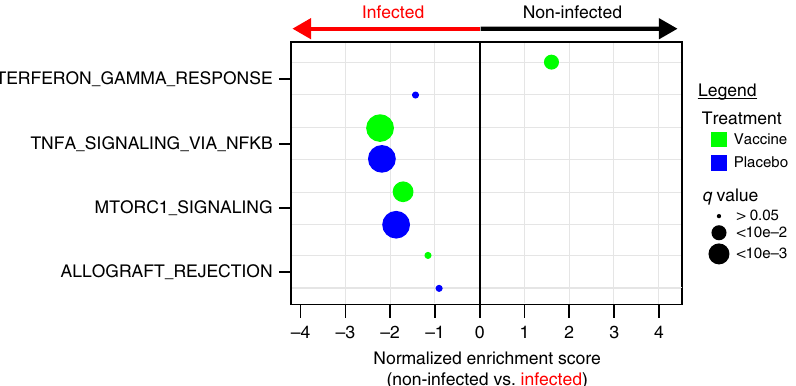
Fig. 3 IFN γ response associated with the reduction of the risk of HIV-1 infection in vaccinees. Dotplot presenting the association between the pathways induced by the RV144 vaccine and HIV-1 infection status, separately for vaccinees and placebo recipients. Gene-expression of 183 vaccine recipients, 30 cases and 153 controls, and 30 placebo recipients, of which 17 were infected, were used for this analysis. GSEA was performed and identi fi ed one pathway associated with the reduction of the risk of HIV-1 acquisition in vaccinees and the two pathways associated with a higher risk of HIV-1 acquisition both in vaccinees and placebo recipients. The normalized enrichment scores (NES) of those pathways are presented on the plot. An NES greater than 0 suggests that participants with higher expression of the genes in that pathway are less likely to be infected by HIV-1 while an NES below 0 corresponds to participants with higher expression of the genes in that pathway and more likely to acquire HIV-1. The size of the dots is proportional to the false-discovery rate ( q value) of the